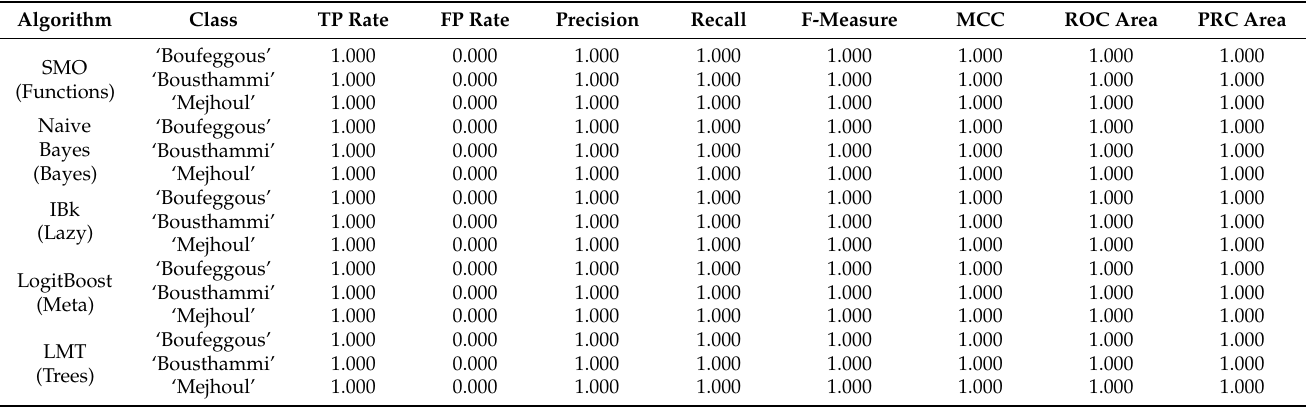
Table 4. Performance metrics of discrimination of ‘Boufeggous’, ‘Bousthammi’, and ‘Mejhoul’ date palm fruits for the models built based on a set of image textures selected from color channels L , a , b , R , G , B , U , V , S , X , Y , and Z